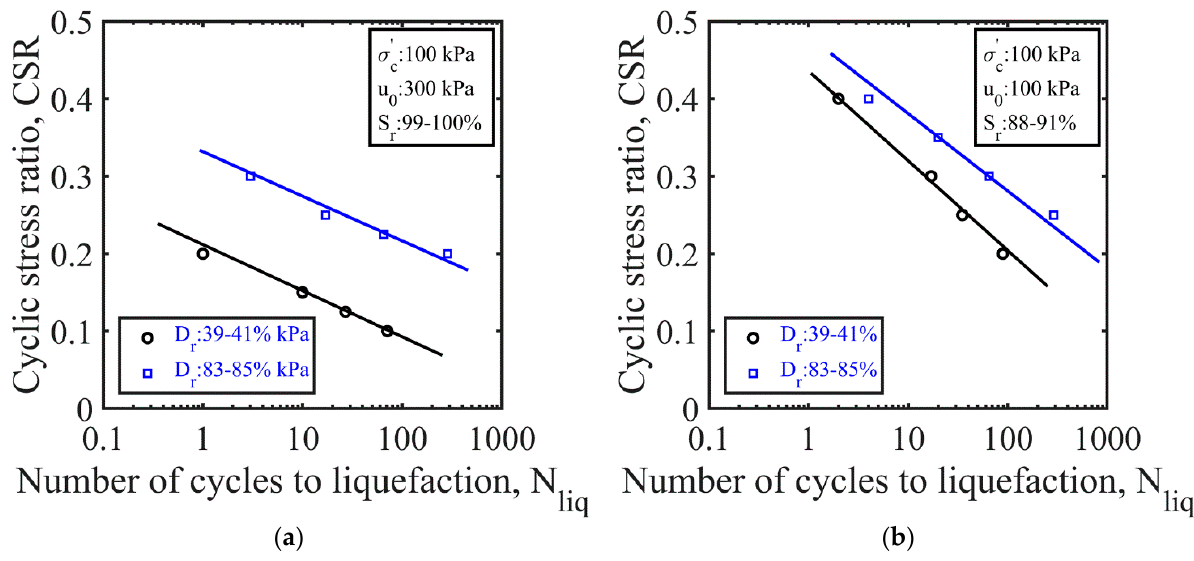
Figure 11. Effect of relative density on liquefaction resistance of sand: ( a ) nearly/fully saturated sand specimens; ( b ) partially saturated sand specimens.